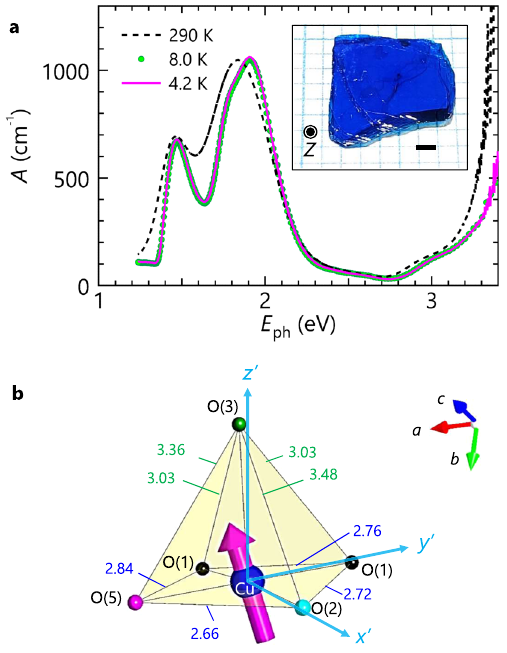
Fig. 3 Optical absorption spectra and local environment of the Cu 2 +